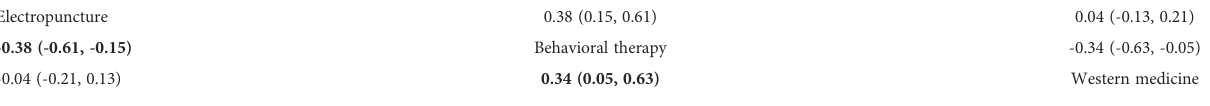
Bold values means the sorting tables represent the area under the curve of the cumulative probability sorting chart, the bold values are the rank of the sorting by different types of intervention in our study. While the number of the ladder table is the relative effect value and 95%